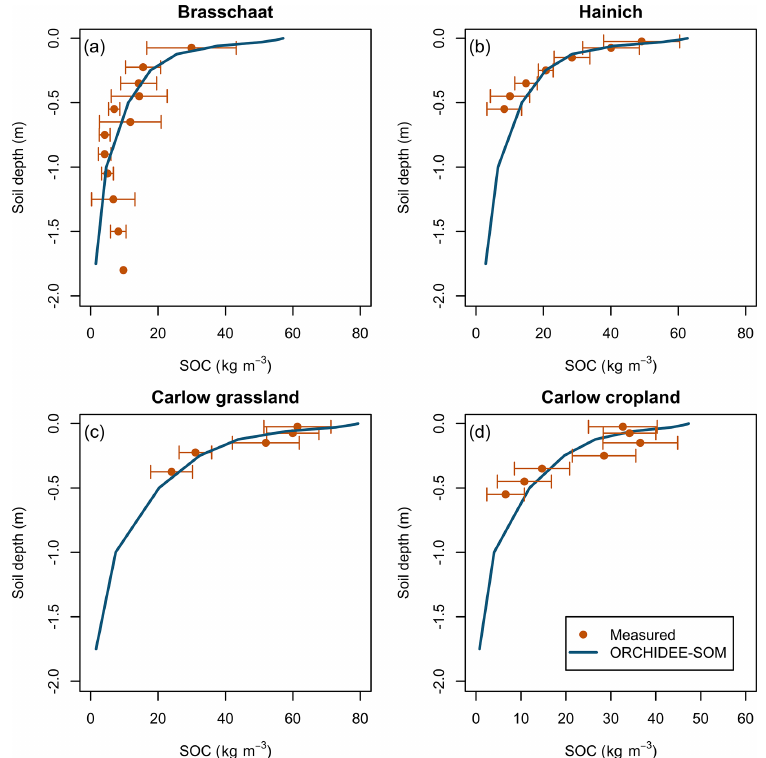
Figure 3. ORCHIDEE-SOM simulated (in blue) and measured (in brown) soil organic carbon profiles at the four sites, (a) Brasschaat forest, (b) Hainich forest, (c) Carlow grassland, and (d) Carlow cropland. Error bars represent the standard deviation of the